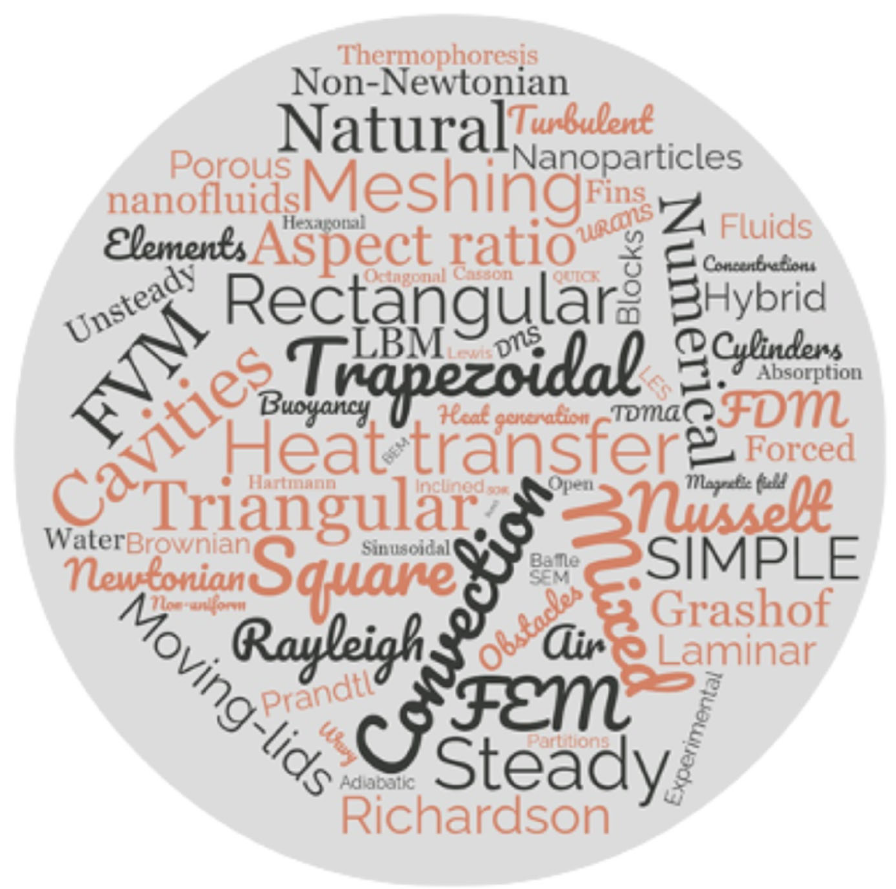
Figure 2. Word Cloud Map.